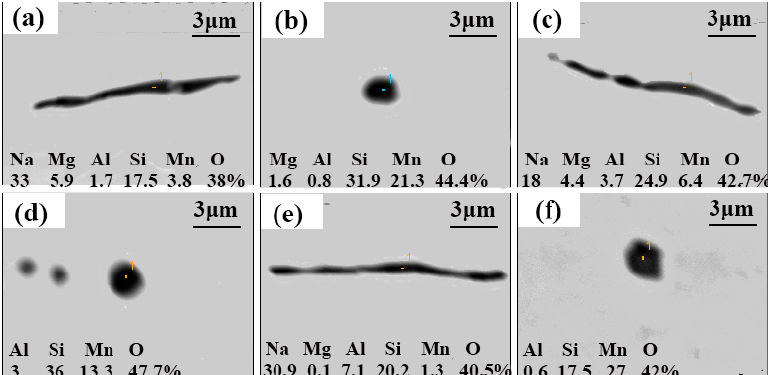
Figure 4. Typical morphology and energy spectrum of Na-containing inclusions.